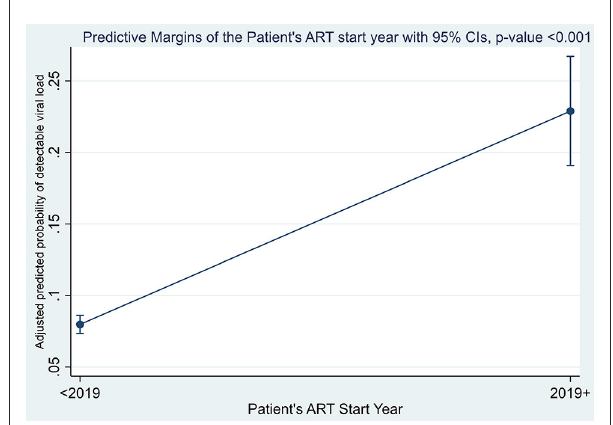
FIGURE2 Margins plot on overall viral detectability among adult PLWHIV by campaign categories.